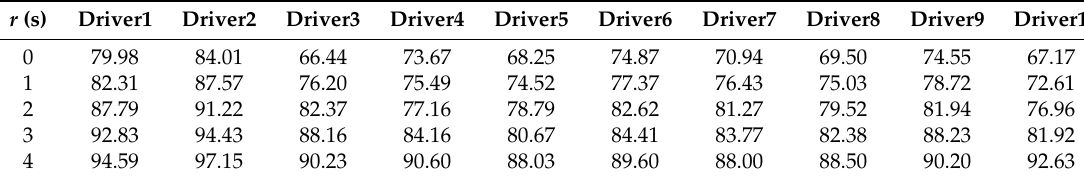
Table 9. Sensitivity (s) of testing data (O2).